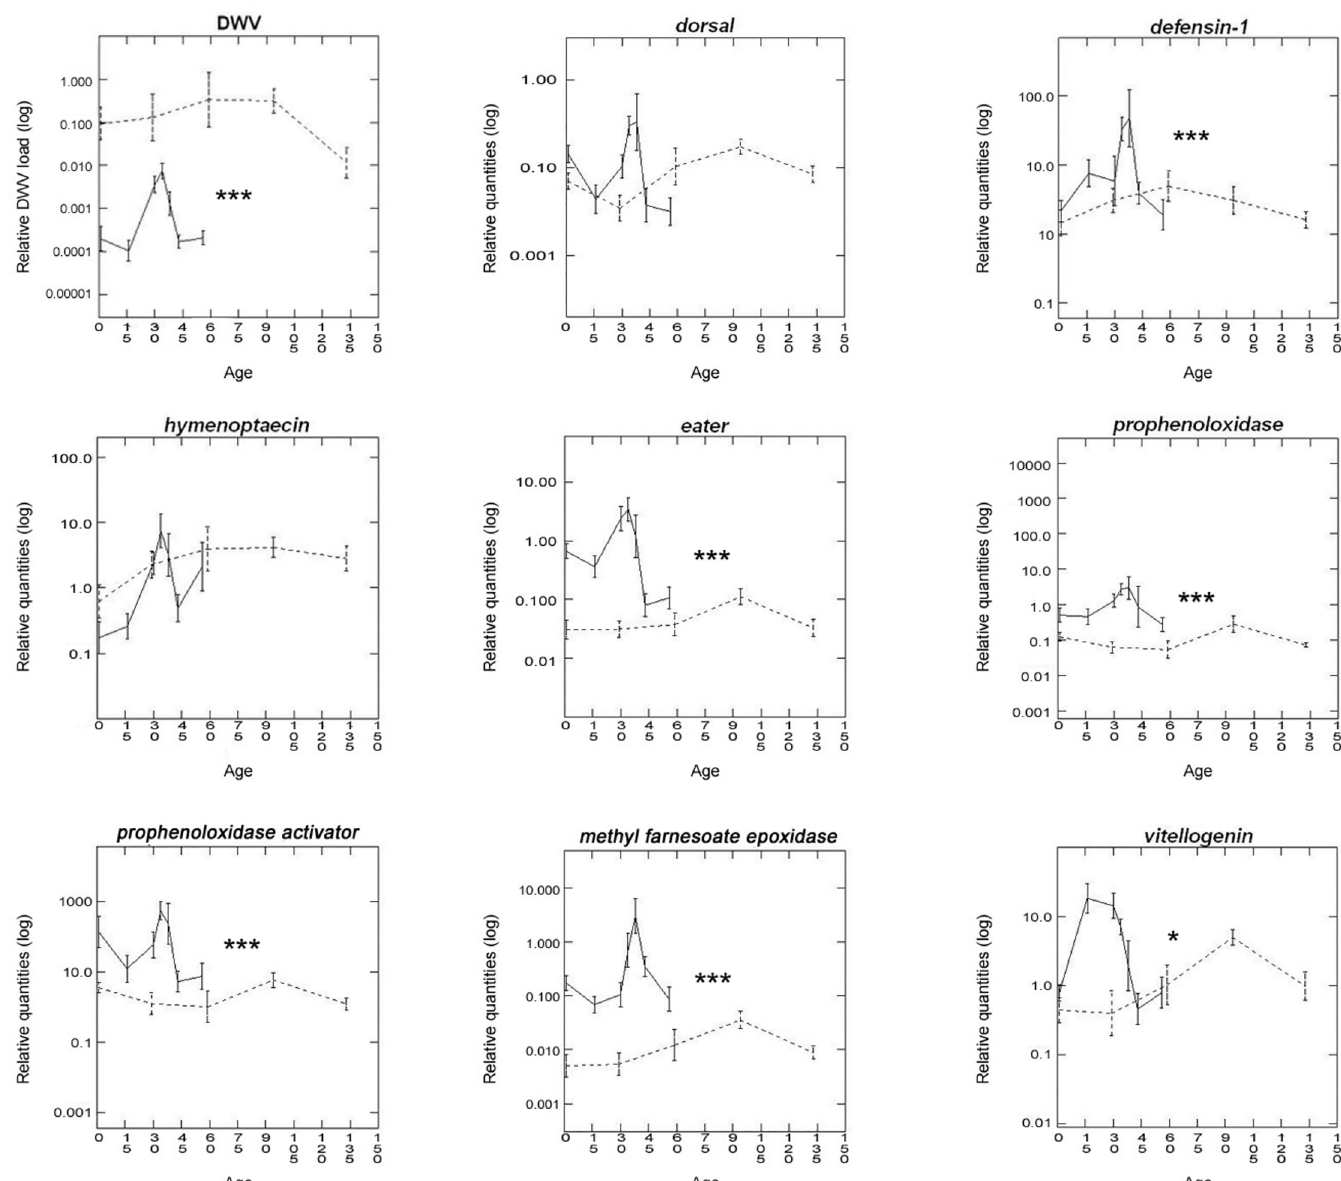
Fig 2. Seasonal variability in gene expression profiles and DWV load. The Y-axis shows the relative quantities of the measured genes, respectively relative genome copies of DWV (log10). The two groups are shown in the X-axis, summer bees (N = 67) winter bees (N = 50). (Mann Whitney U test, significant differences are indicated with * P < 0.05; *** P <